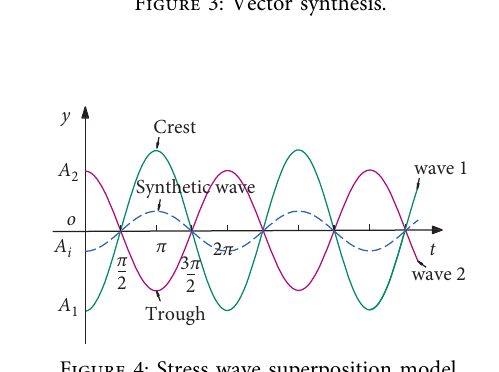
Figure 4: Stress wave superposition